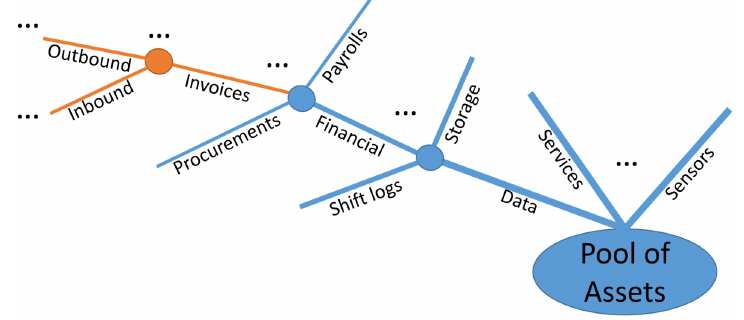
Figure 2. Selected branch of asset taxonomy.